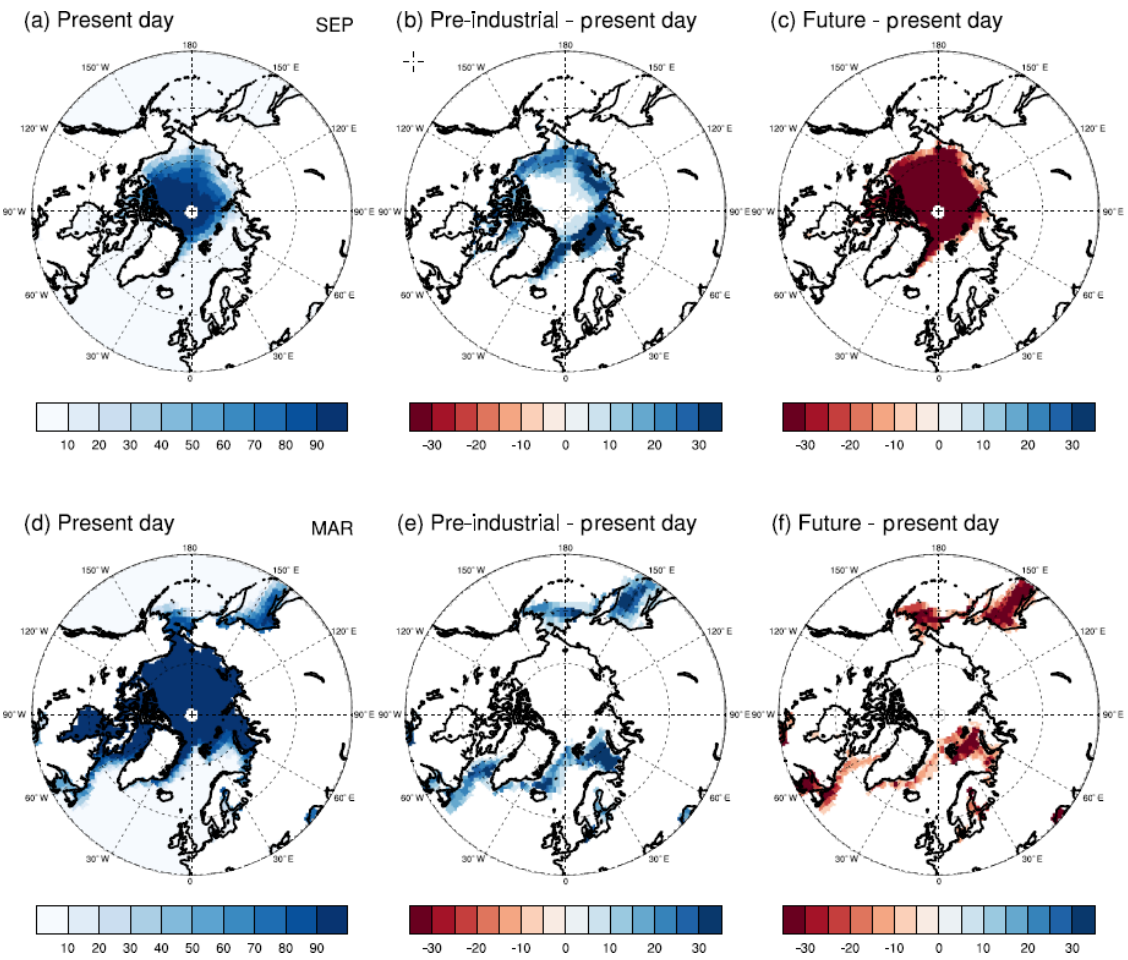
Figure 5. Arctic sea ice forcing fields. Present-day Arctic sea ice concentration for (a) September and (d) March. Differences from present- day fields are shown for (b, e) pre-industrial and (c, f) future